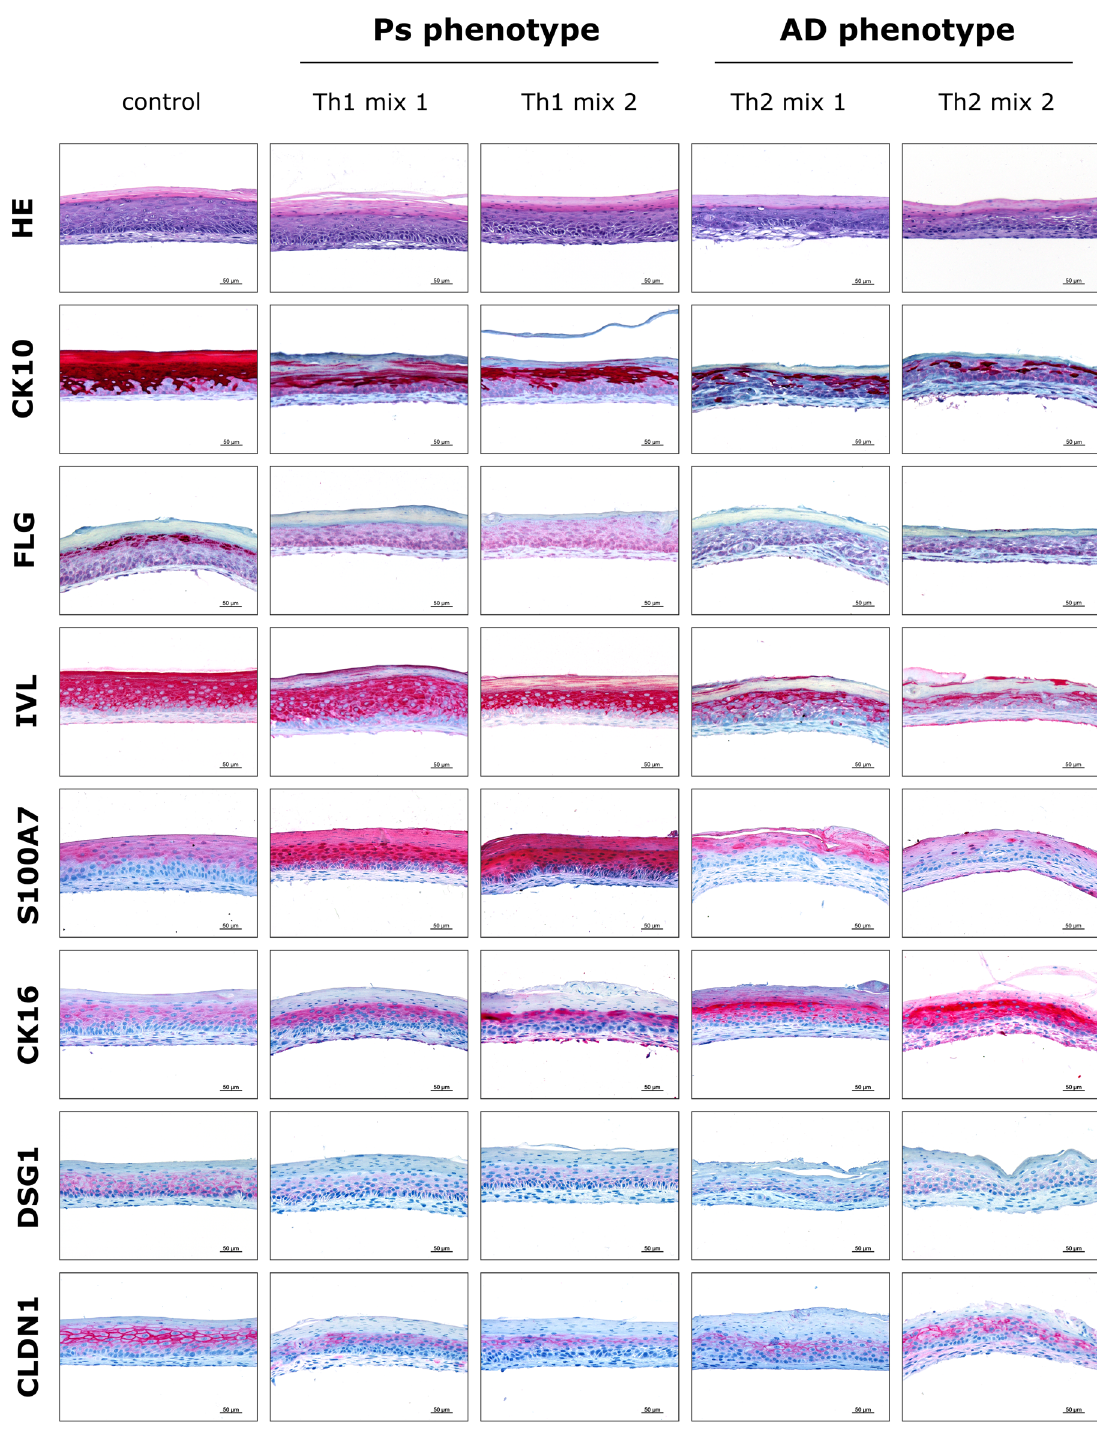
Figure 1. Histological alterations in disease-associated skin models. Microanatomy of the skin models was revealed by HE staining. IHC staining was used for visualization of differentiation markers/structural proteins (CK10, FLG, IVL, CK16), antimicrobial peptides (S100A7) and cellular contact proteins (DSG1, CLDN1) of skin equivalents stimulated with Th1 or Th2 cytokine mixes compared to an unstimulated physiological control. Scale bar: 50 µm; pictures are representatives of n = 2 experiments with a total of 4 skin models (keratinocytes derived from one